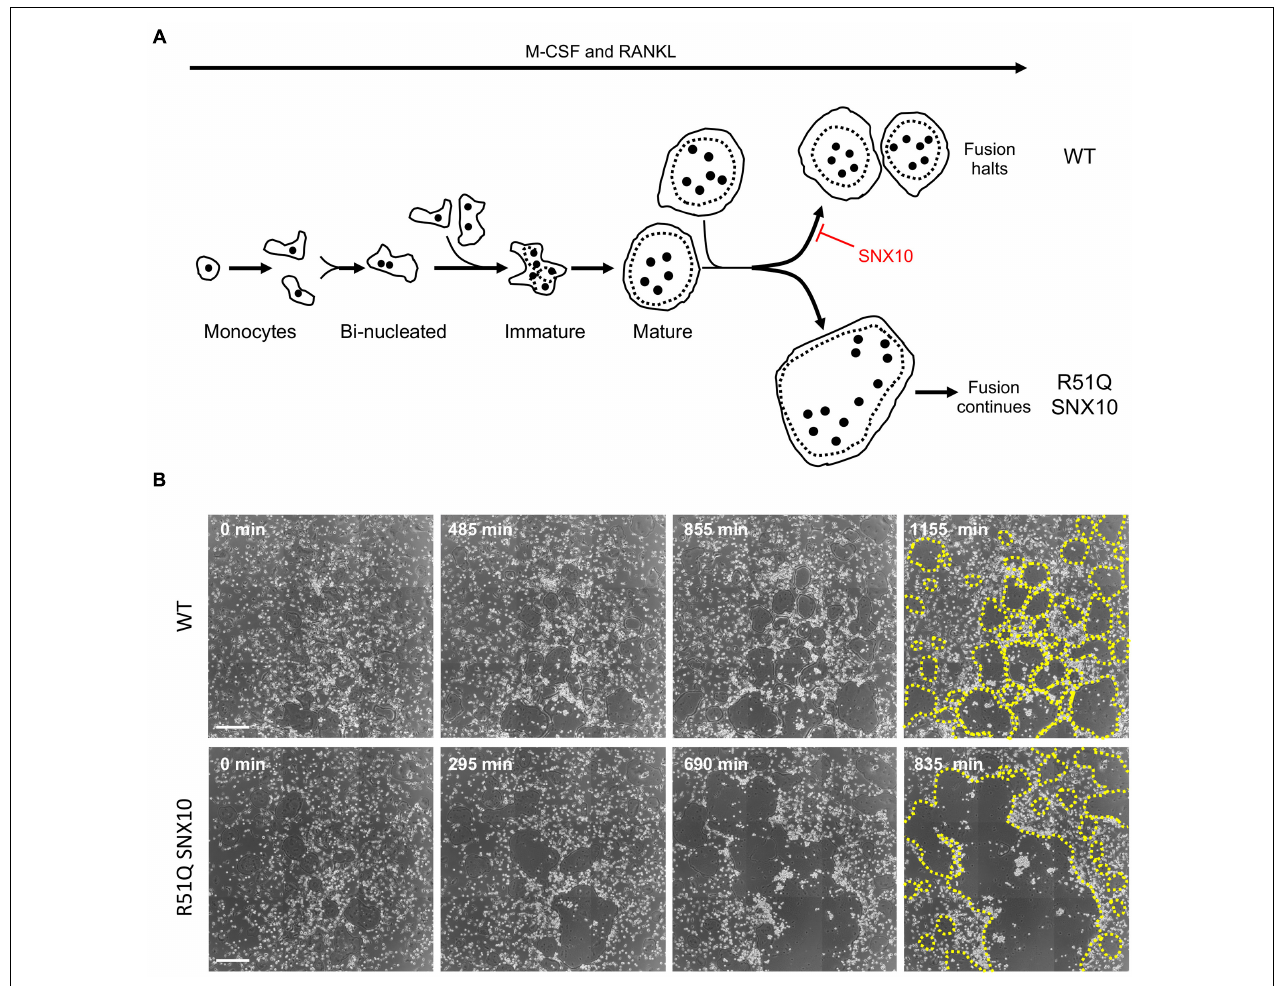
FIGURE 5 | Uncontrolled fusion of mature R51Q SNX10 OCLs. (A) Outline of osteoclastogenesis in culture, similar to Figure 1A . Top: WT mature OCLs do not fuse with each other. Bottom: Mature R51Q SNX10 OCLs readily fuse with each other and continue to fuse with other mature OCLs. (B) Phase light microscopy images of cultures of WT (top) and R51Q SNX10 (bottom) spleen-derived monocytes undergoing osteoclastic differentiation on glass coverslips in the presence of M-CSF and RANKL. Note development of mature, round WT OCLs that remain juxtaposed with each other, vs. continuous fusion that generates giant R51Q SNX10 OCLs (Barnea-Zohar et al., 2021). Times are noted from start of imaging; OCL boundaries are indicated by dashed yellow lines in the final image of each series. Each image is a composite of nine smaller images. Scale bars: 250 µ